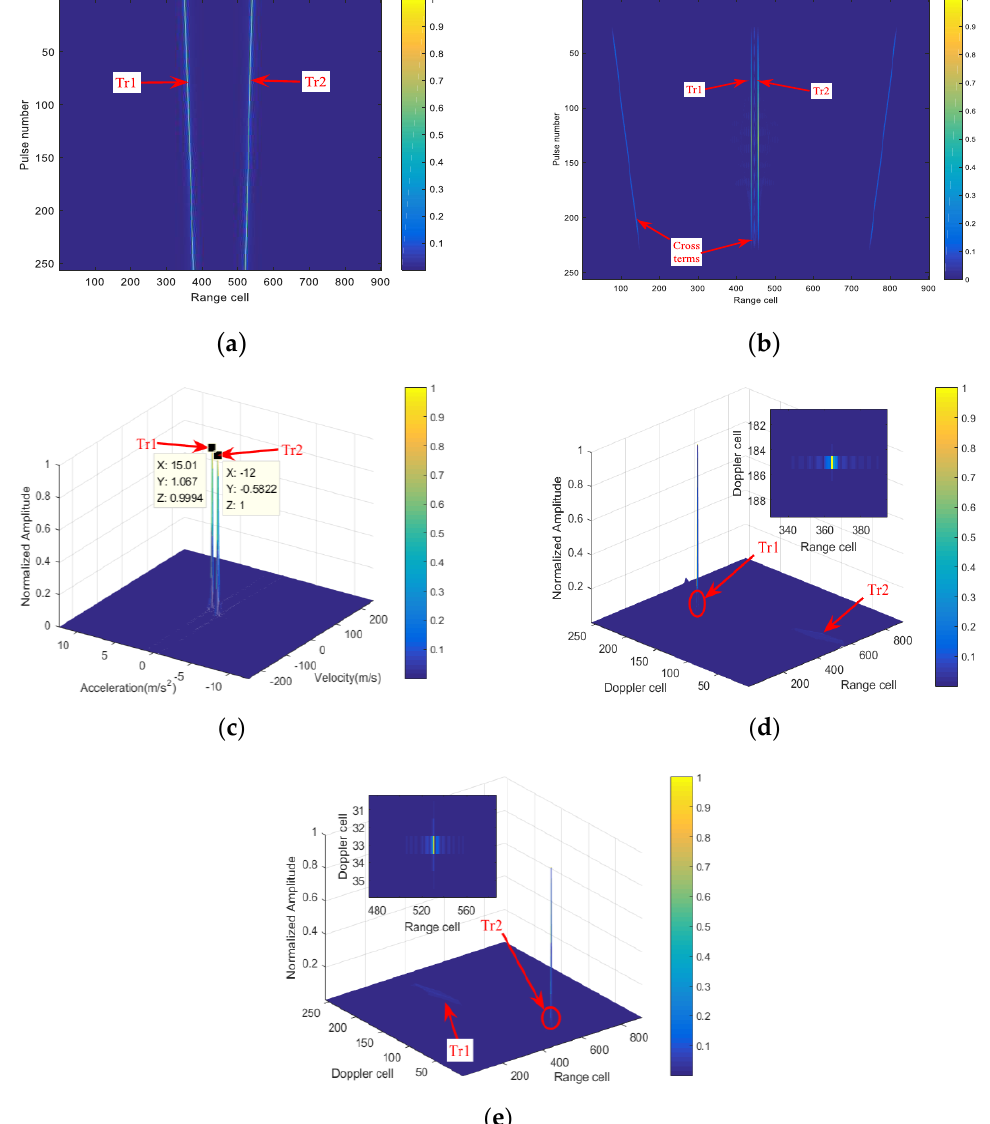
Figure 2. Simulation results of Example 2. ( a ) The result of pulse compression; ( b ) the result of FD-SoPD; ( c ) the velocity-Acceleration distribution; ( d ) coherent integration result of Tr1; ( e ) coherent integration result of Tr2.